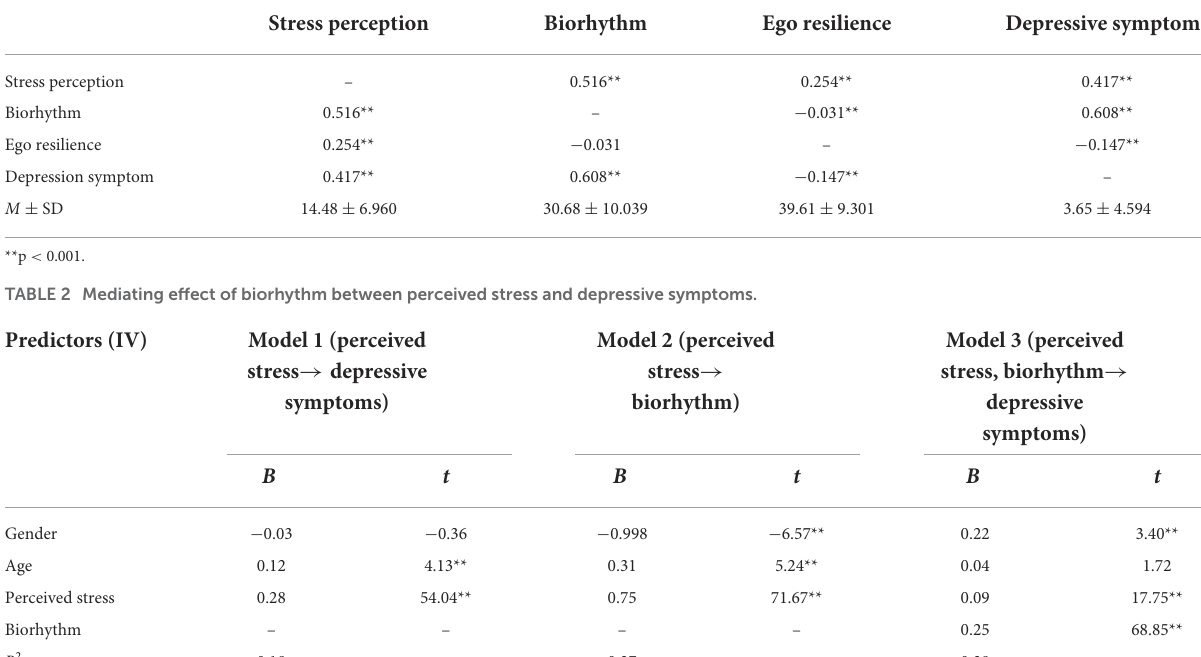
TABLE 1 Correlations ( r ) between perceived stress, biorhythm, ego resilience and depressive symptoms ( n = 13,943).